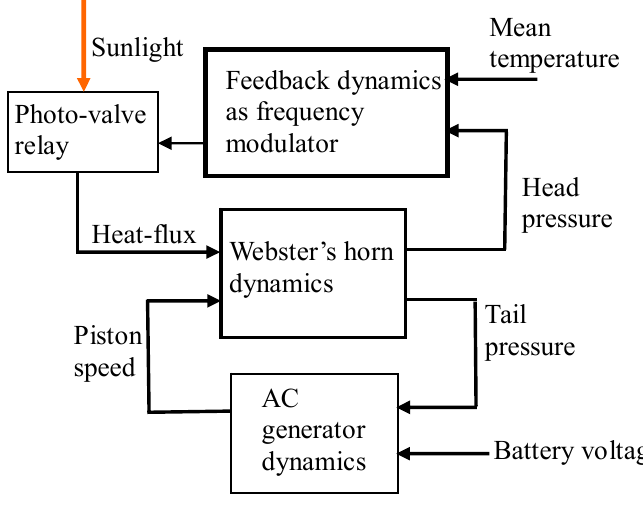
Figure 7. Feedback-representation for the entire